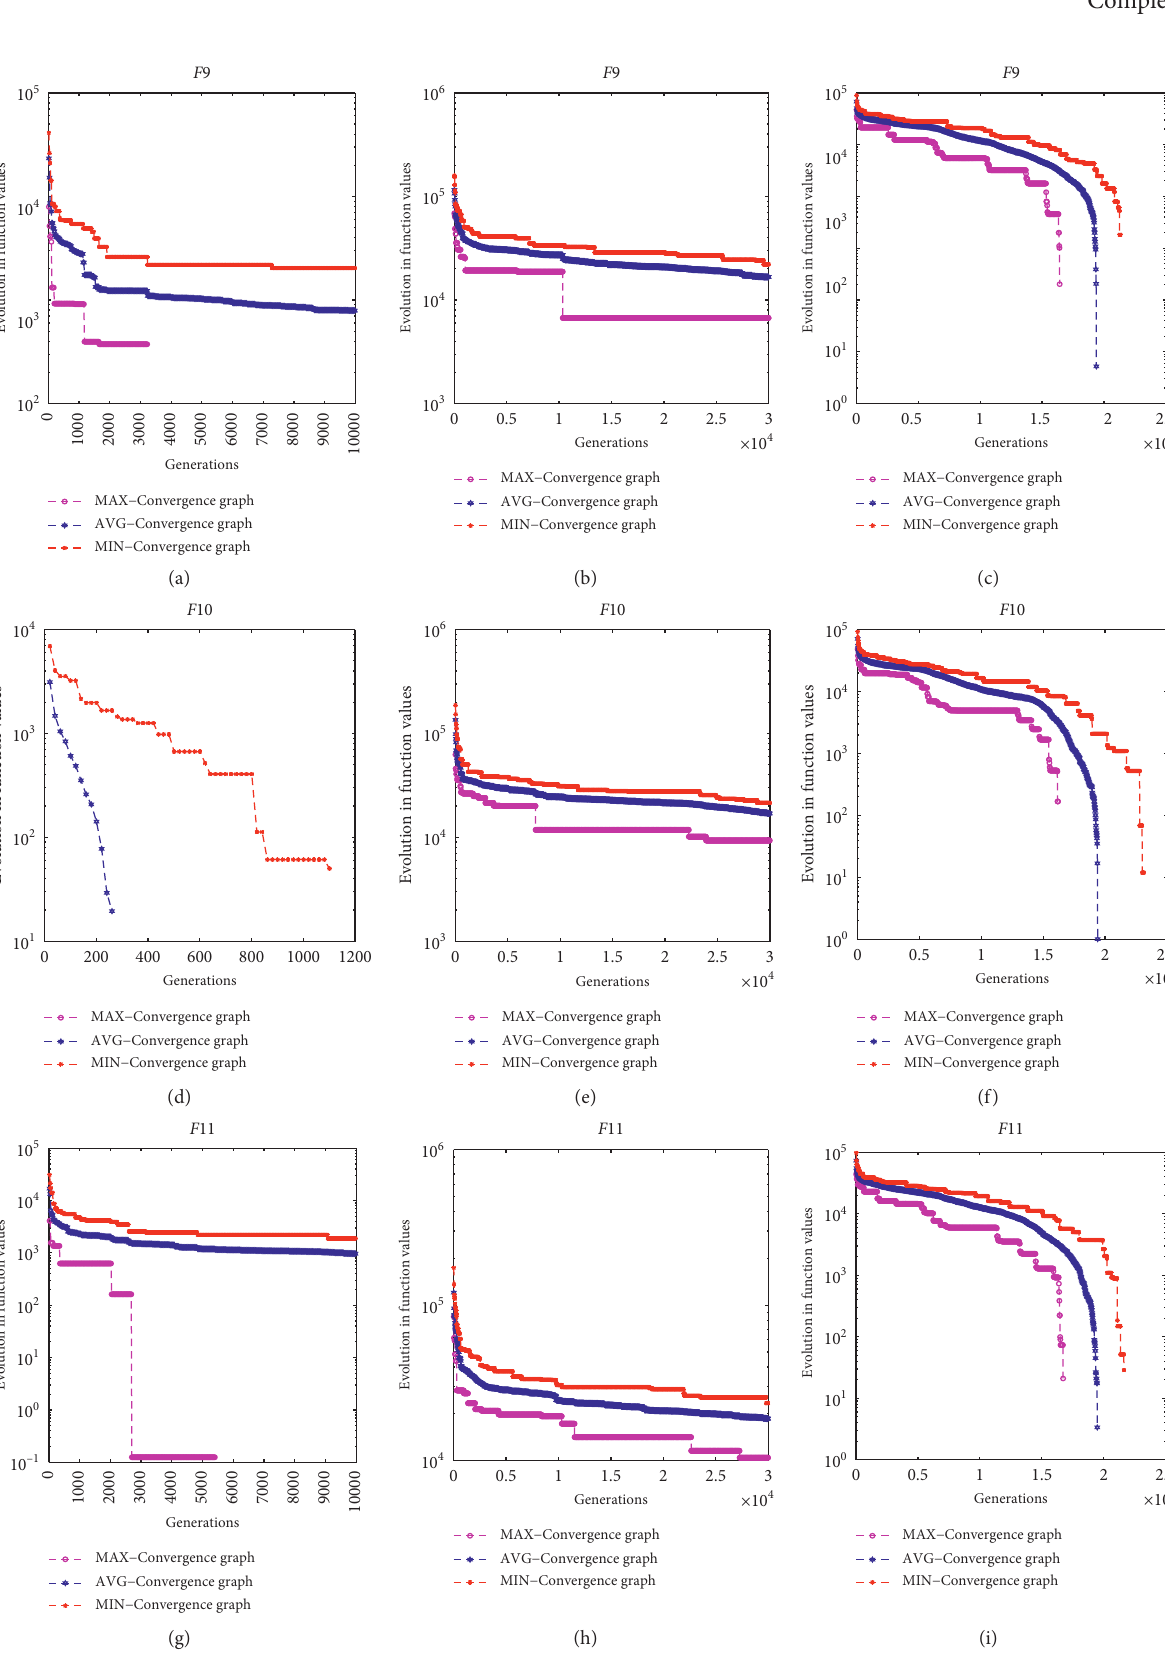
to F benchmark 9 11